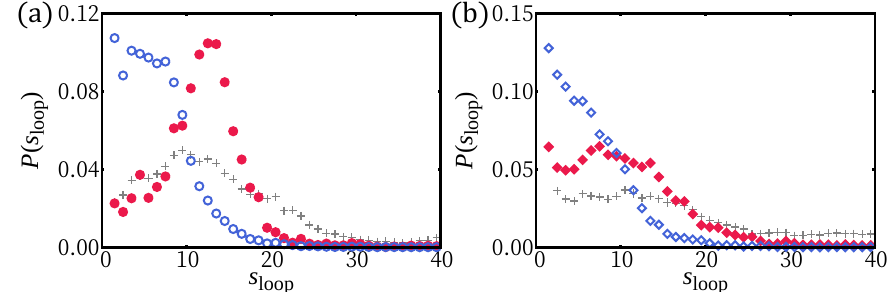
Figure 3. The loop length distributions for: ( a ) γ > 1 ( ◦ ); and ( b ) γ < 1 ( (cid:5) ). Loop length is defined as the segment length that consecutively belongs to | z | > 0.2. Two representative regimes, weak confinement regime k = 0.05 and strong confinement regime k = 1.0, are shown by filled and empty symbols, respectively. The loop distribution with k = 0 is shown as gray symbols (+) for comparison. For γ > 1, the loop length making half of the 3D helical period is most prevalent at weak confinement. Smaller loops are equally common for γ < 1, where the H-filament is more confined (see Figure 1a). Strongly confined segments show almost flat distributions for γ > 1 and two sub-populations for γ < 1.